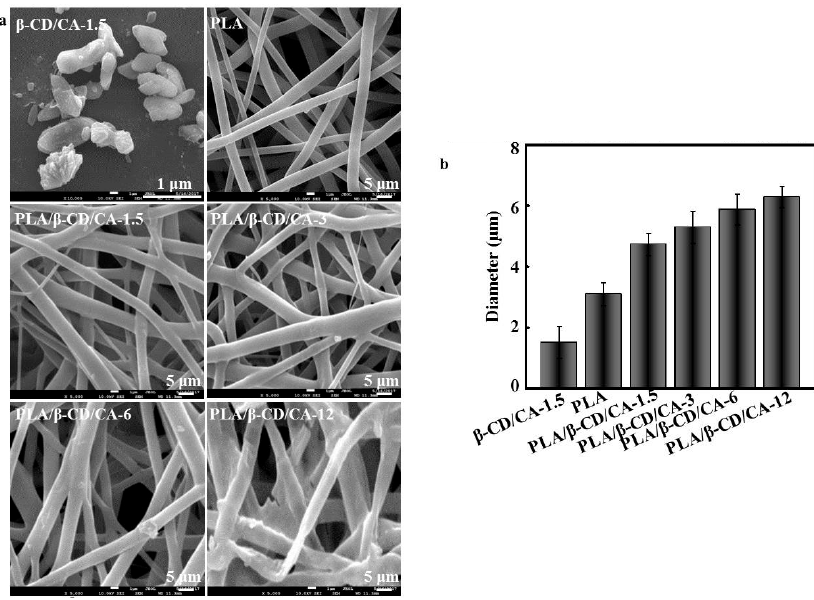
Figure 1. ( a ) SEM images of β -CD/CA-1.5 particle and PLA/ β -CD/CA fibers; and ( b ) the average diameters of different fibers determined from SEM images.